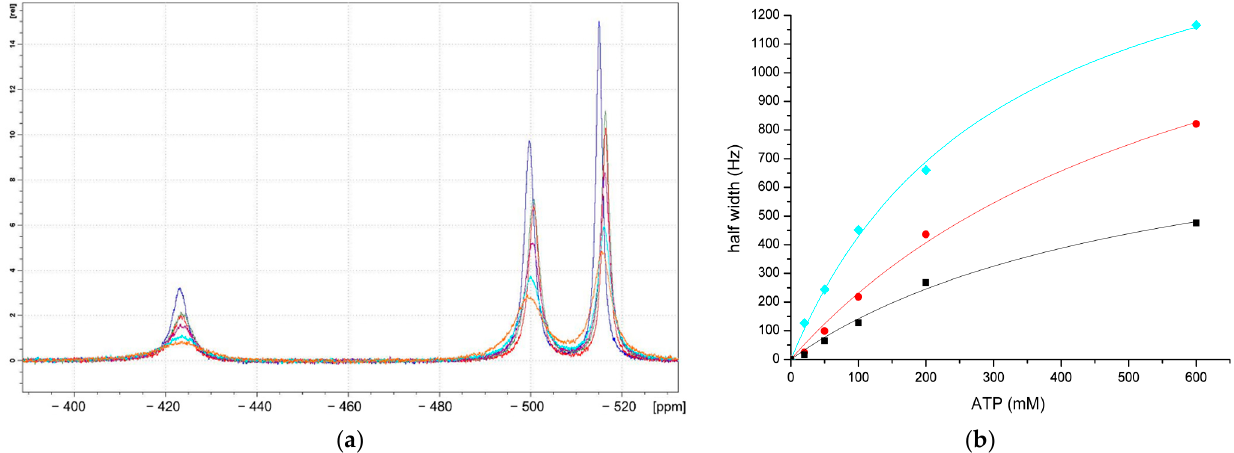
Figure 5. ( a ) Overlay of 51 V ‐ NMR spectra of 20 mM V 10 at pH 4.0 (measured at room temperature) and 50 °C upon addition of ATP: 0 mM (blue), 20 mM (red), 50 mM (green), 100 mM (purple), 200 mM (cyan) and 600 mM (orange). ( b ) Plot of the half width of V 10 resonances in 51 V ‐ NMR as a function of ATP concentration. The V 10 resonance at − 423 ppm is presented in cyan, the resonance at − 500 ppm in red and the resonance at − 516 ppm is presented in black.